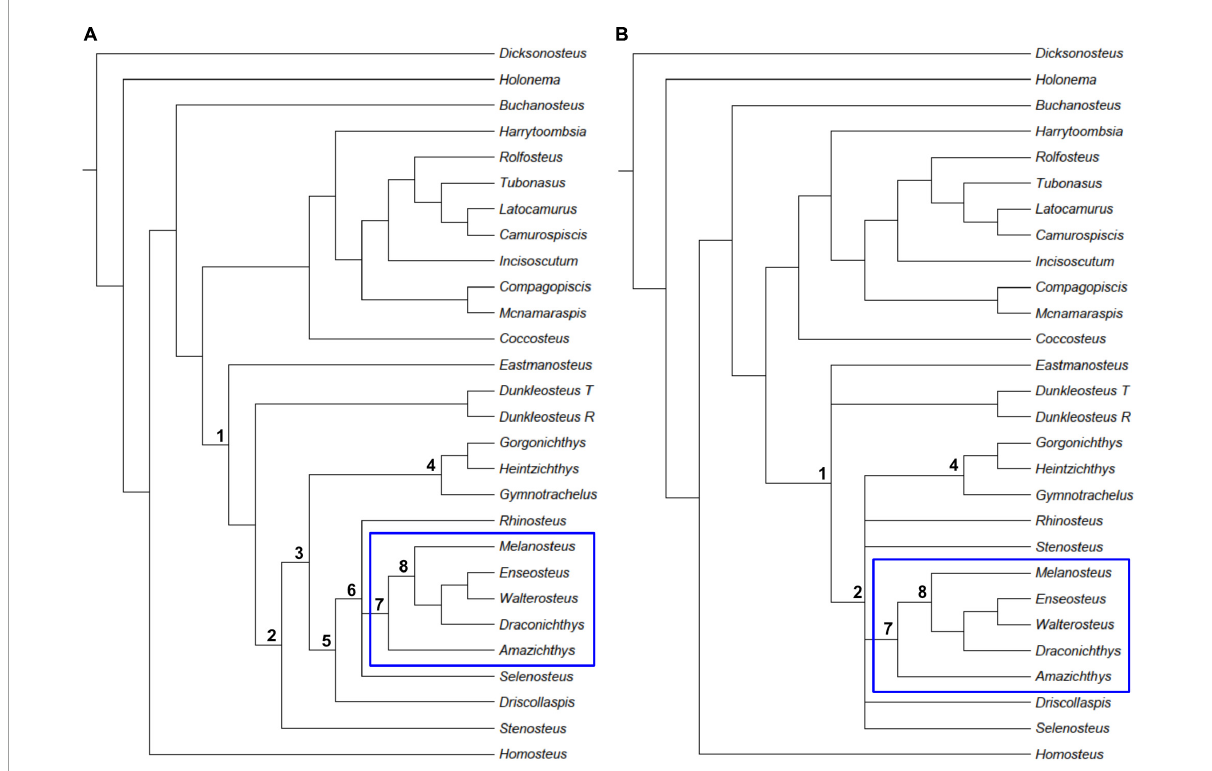
FIGURE8 Phylogenetic analysis of eubrachythoracid arthrodires and the position of Amazichthys trinajsticae gen. et sp. nov. Strict consensus tree (A) and majority rule consensus tree (B) . Clade 7, in which A. trinajsticae is nested, is highlighted by the blue rectangle. 1. Pachyosteomorphi, 2. Aspinothoracidae, 3. Selenosteidae, 4–8. unnamed